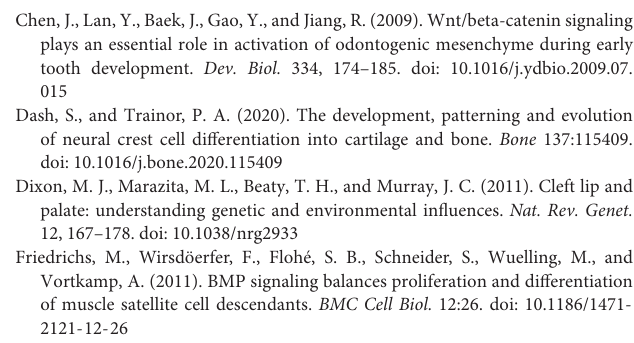
Supplementary Figure 1 | The fluorescence pattern in Osr 2-cre Ki ; Rosa26R-mT/mG soft palate. (A) The Tvp level of soft palate in E16.5 Osr 2-cre Ki ; Rosa26R-mT/mG mouse. White dotted line delineated aponeurosis; asterisk meant Hpp; the white arrows pointed to the Tvp tendons; white